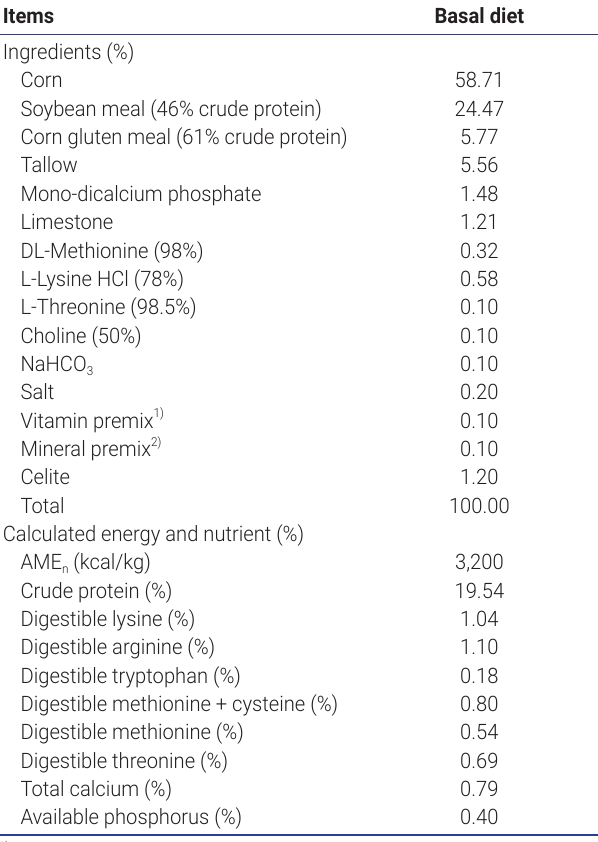
Table 1. Composition and nutrient concentration of the basal